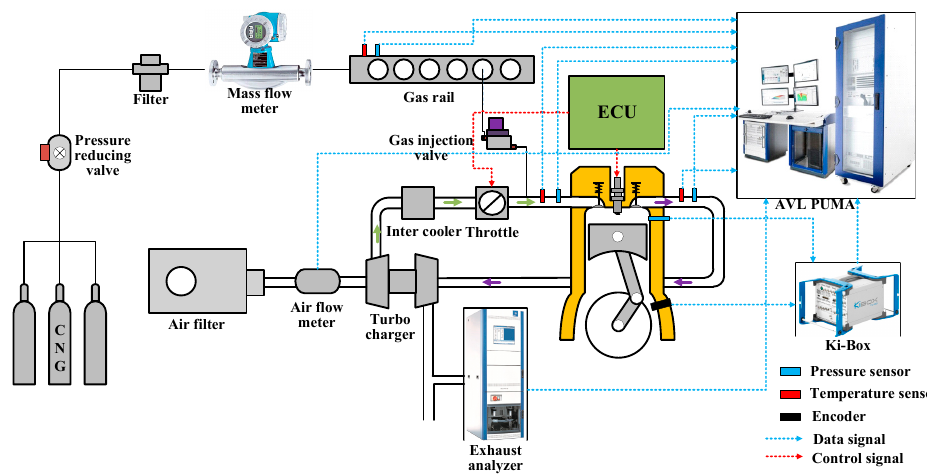
Figure 1. Schematic diagram of engine test bench.